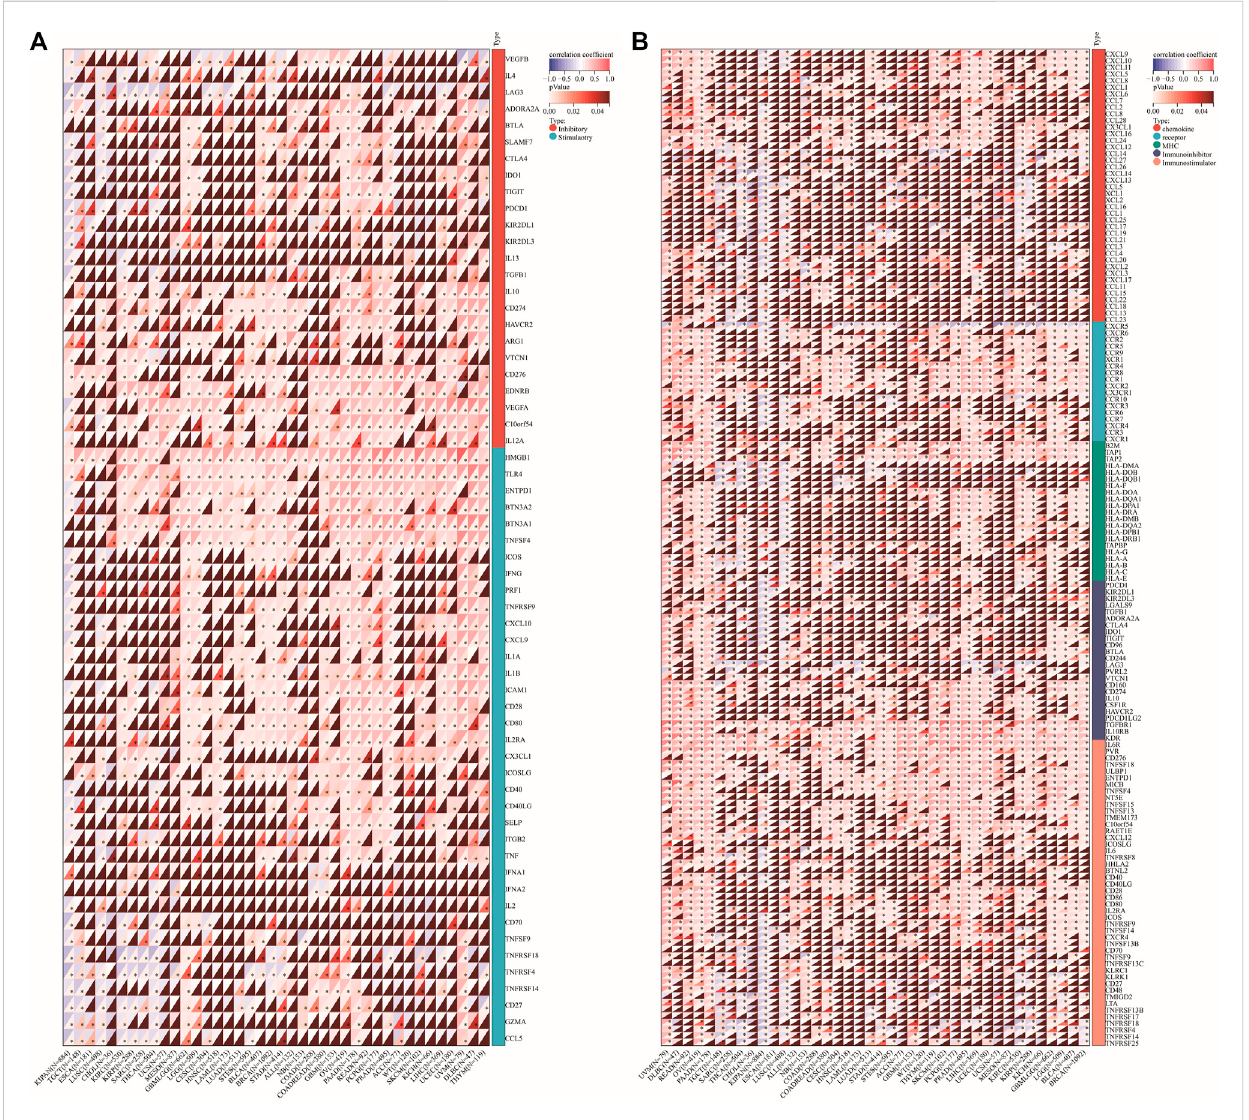
FIGURE 13 Correlation of DLD expression with immune checkpoint genes or immunoregulatory genes. (A) Immune checkpoint genes. (B) Immunoregulatory genes. * p < 0.05.